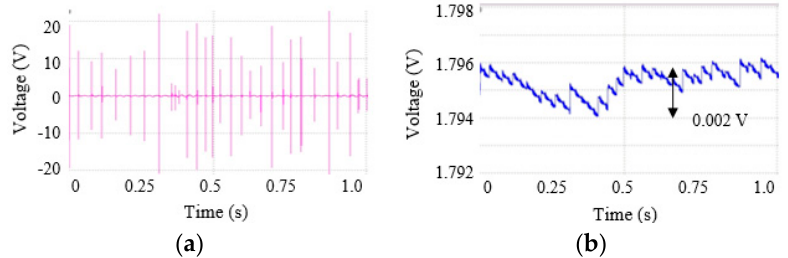
Figure 8. Simulations results in case of irregular vibrations: ( a ) Reference vibration is 13.5 Hz excitation with 3.0 g acceleration, a generated voltage by the harvester, ( b ) VDD of the neural recording circuits.